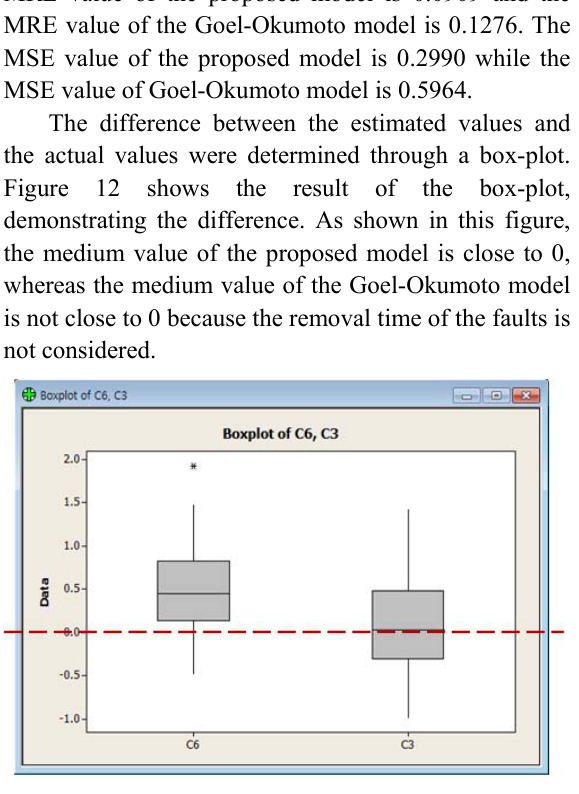
Fig. 12. Results of a Box-plot of the Goel-Okumoto and the Proposed Model